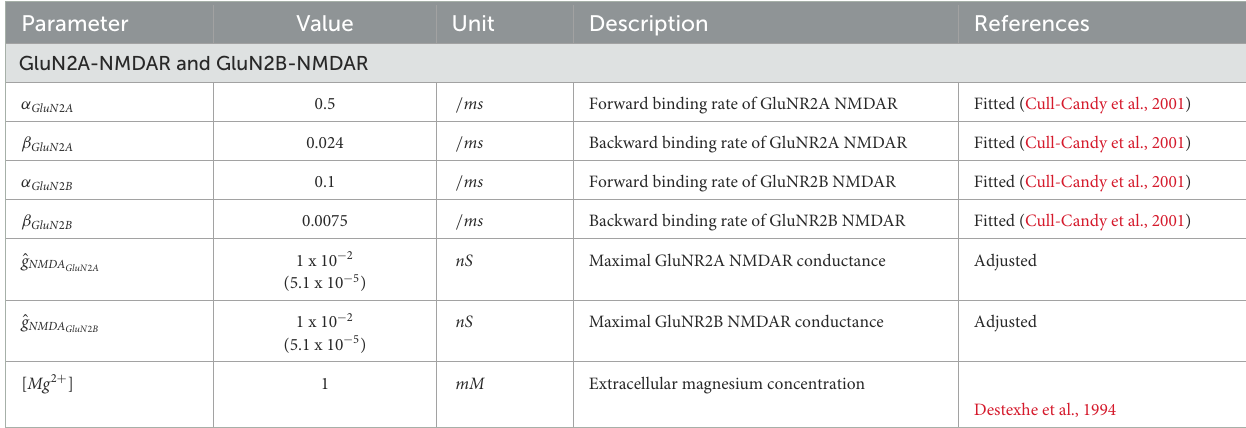
Parametervaluesarepresentedforsynapsesintwo-compartmentalmodelandmulticompartmentalmodel(inparentheses,ifdifferent)ofCA1pyramidalneuron. postsynaptic spike. The number of postsynaptic spikes was varied from one to four with a temporal difference 1 T = 10 ms between pre- and the first postsynaptic spike (Inglebert et al.,